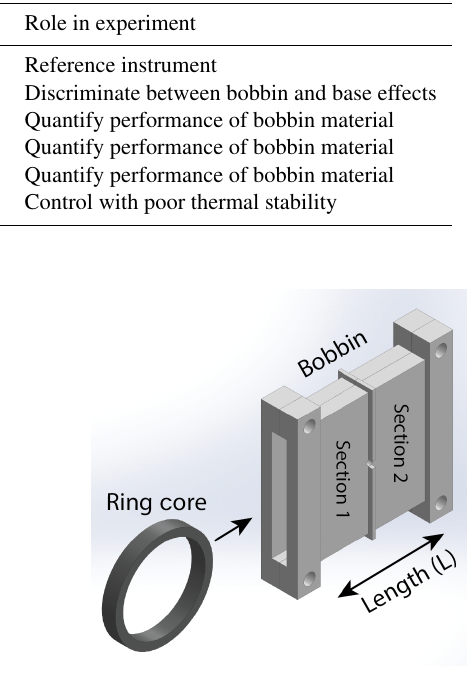
Figure 5. Sensor axis constructed from a ferromagnetic ring core with a toroidal drive winding inserted in a bobbin which supports the combined sense–feedback